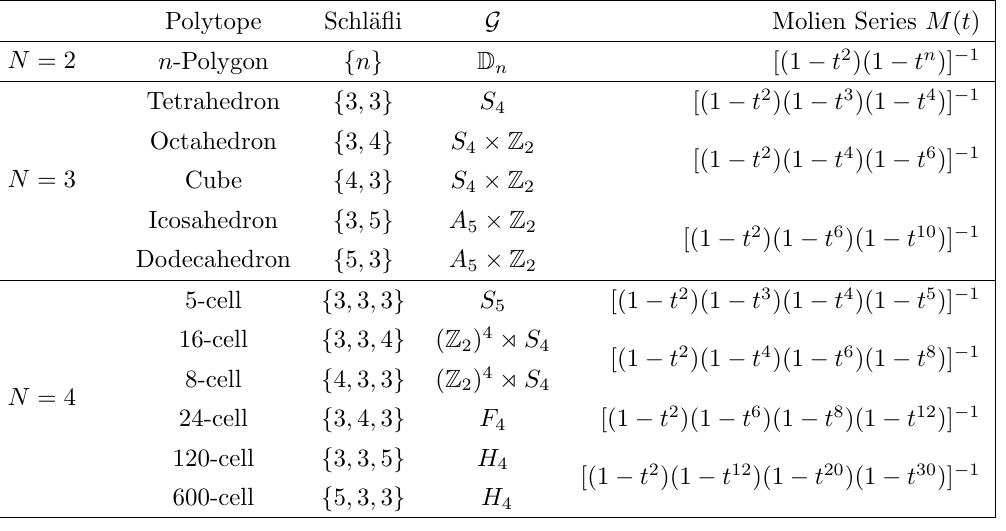
Table 1 . Polytopes symmetry groups G along with the corresponding Molien series. The groups F 4 and H 4 are named according to the Coxeter